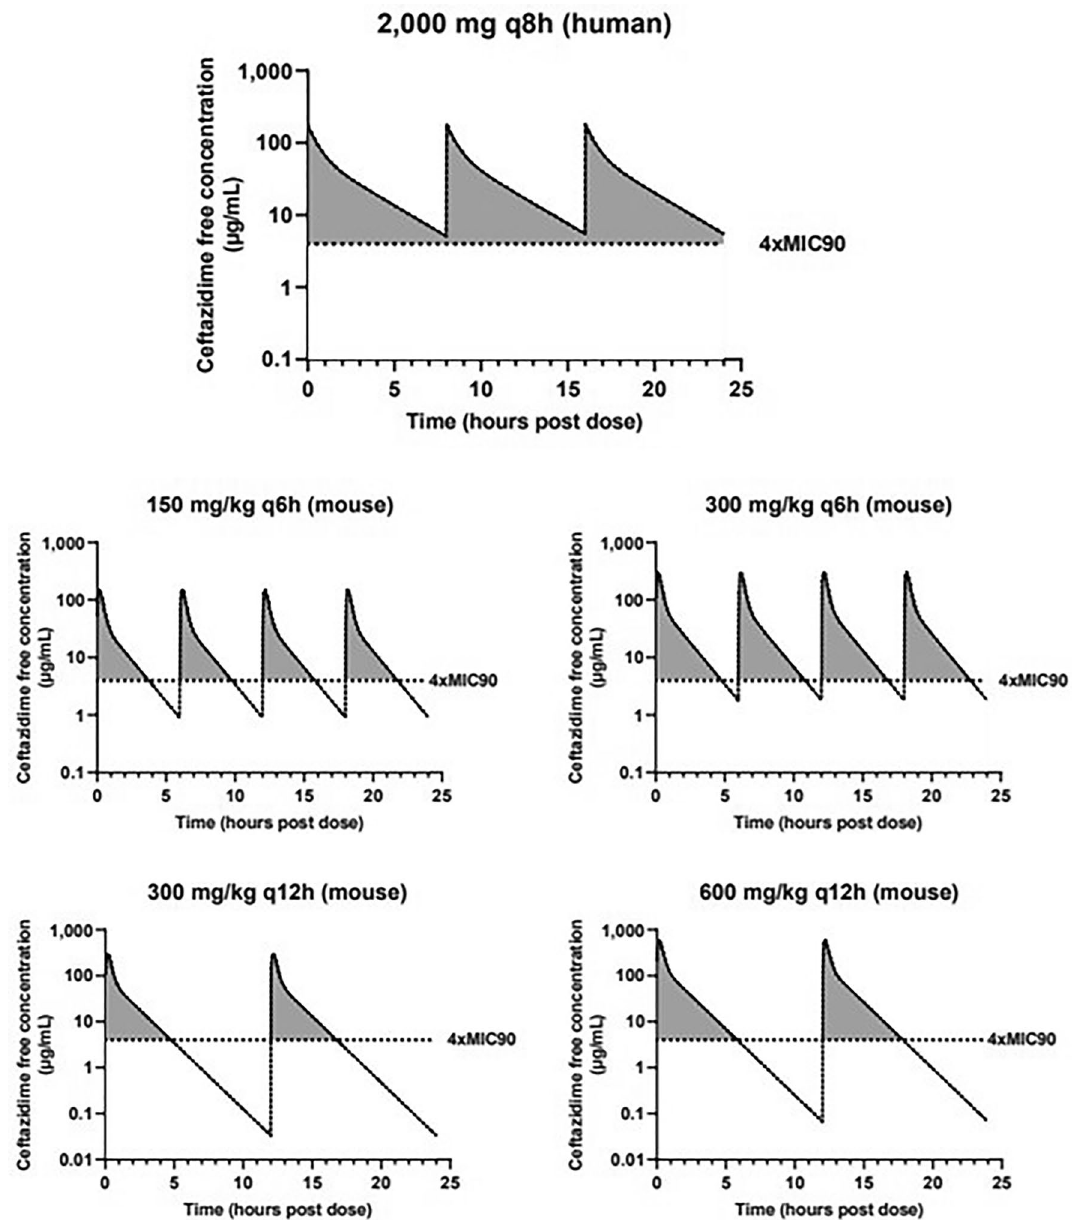
Figure 5. Predicted concentration–time profiles for murine and human dosing regimens. Predicted concentration–time profiles for murine and human ceftazidime dosing regimens, modeled using a PK/PD driver of 100% f T > 4*MIC. The clinical dose of 2000 mg (IV infusion) of ceftazidime every 8 h resulted in an estimated 100% f T > 4 μg/mL. In the infected murine model greater PK/PD drivers of 87.2% and 69.8% f T > 4 μg/mL were estimated for 300 mg/kg and 150 mg/kg QID regimens, respectively compared to lower PK/PD drivers of 52.3% and 43.7% f T > 4 μg/mL estimated for the 600 mg/kg and 300 mg/kg BID dosing regimens,